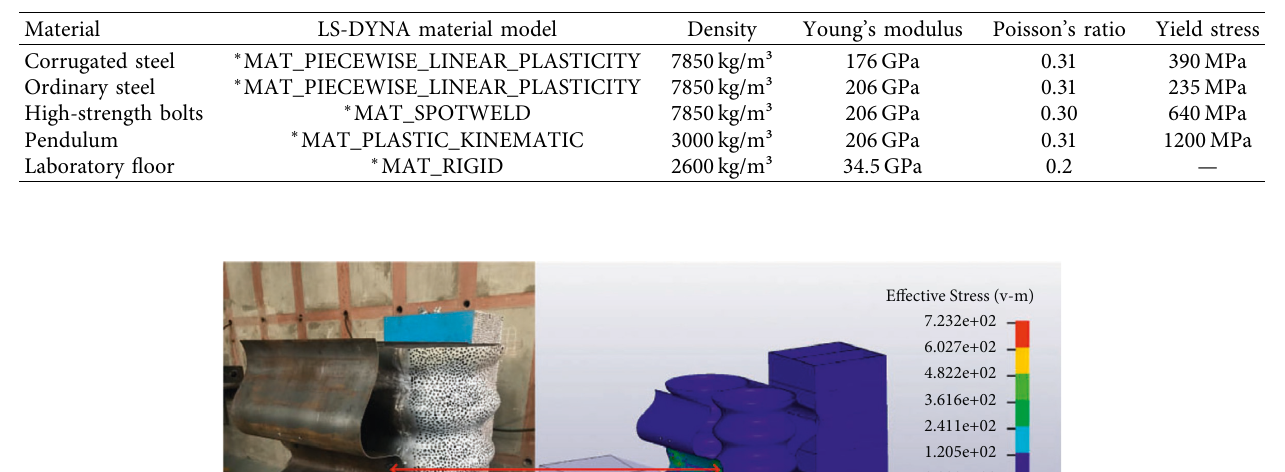
Table 2: Material characteristic parameters.